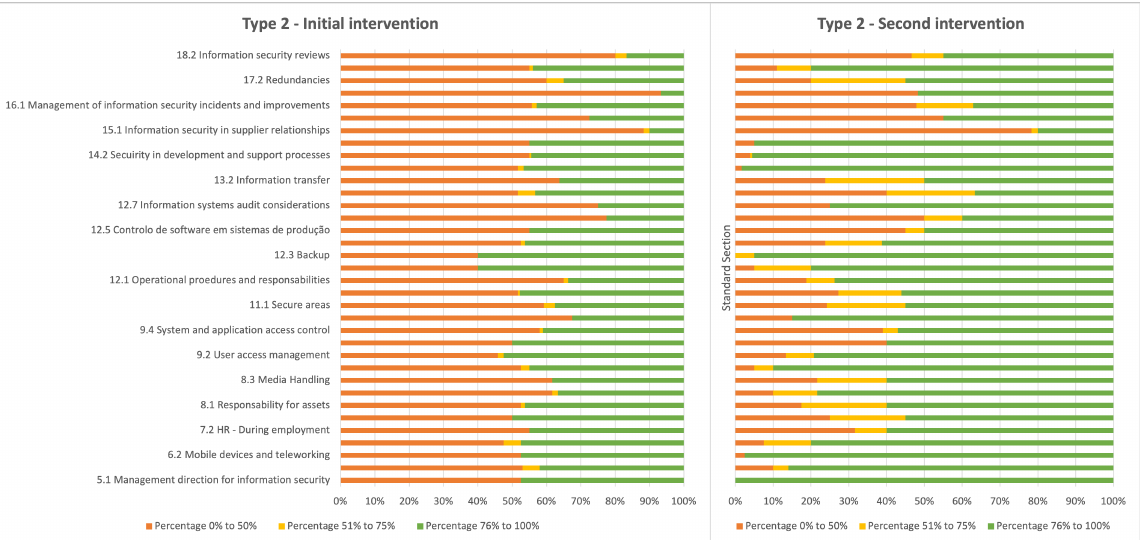
Figure 6. Type 1 results summarizing all the controls assessed in the audit.